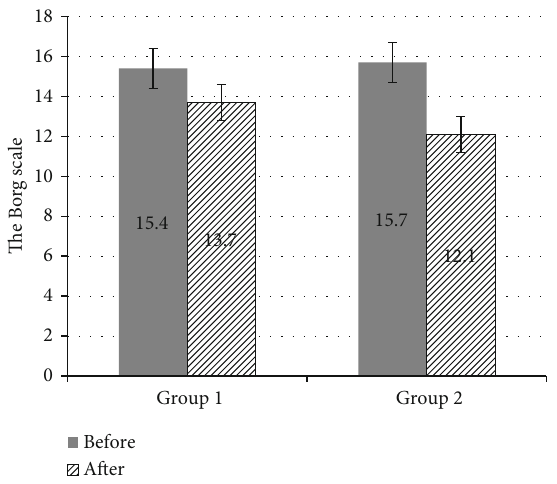
Figure 2: The mean scores before and after the treatment in groups 1 and 2 according to the Borg scale.